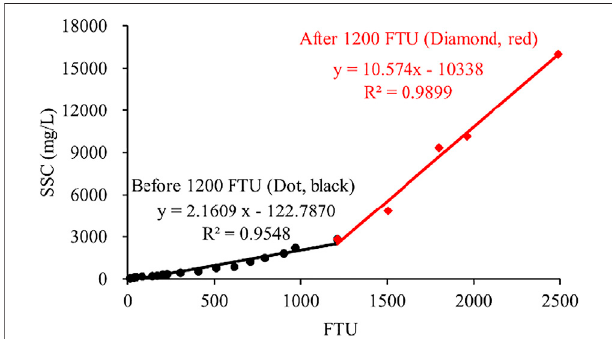
FIGURE 4 | Calibration curves used to convert optical turbidity (FTU, recorded by OBS) to suspended sediment concentration (SSC, mg/L). The trend varies signi fi cantly from low to high turbidity, according, we classify the data into two groups: the black line shows the calibration curve below 1,250 FTU, and the red line shows the calibration curve above 1,250